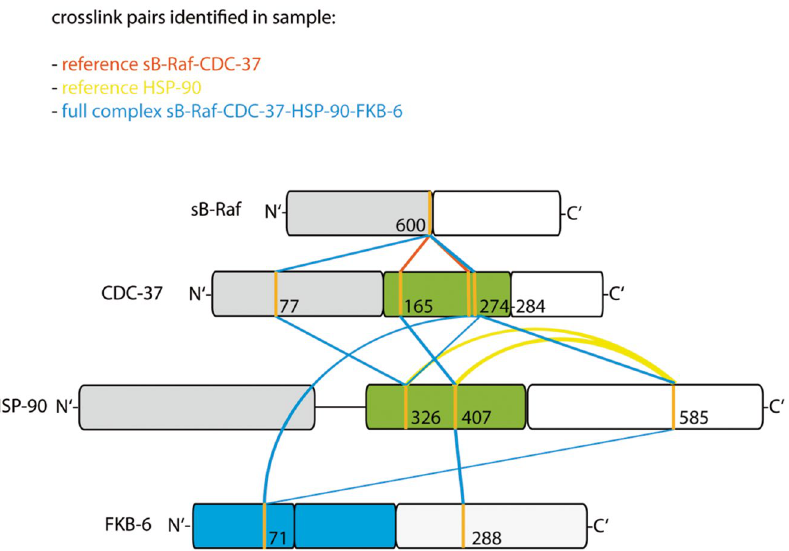
Figure 6. Structural information obtained from MS analysis. Schematic diagram of key crosslinked pairs in the complex. Red lines indicate crosslink in the sample sB-Raf•CDC-37; Yellow lines indicate pairs identified in the HSP-90 sample; Blue lines indicate pairs from the complex sample. N-terminal domains are colored in gray; C-terminal domains in white; Middle domains in green and FK-domains in